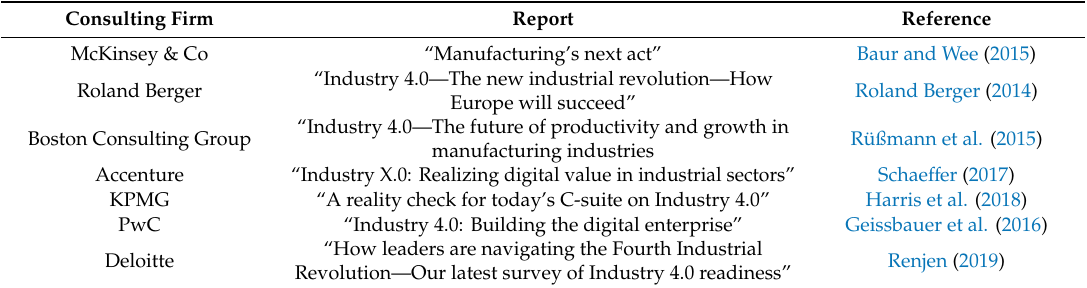
Table 5. Examples of consulting firm reports about I4.0 (Source: author’s own